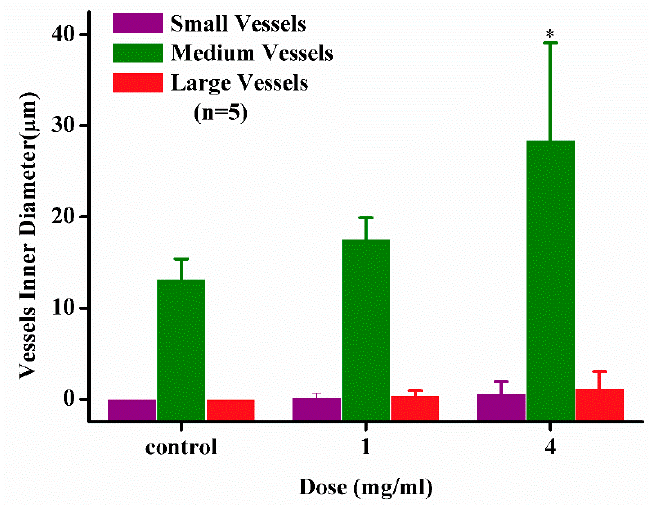
Figure 5. Effect of compound 8 on angiogenesis promotion. * p < 0.05; large vessels: inner diameter > 100 μ m; medium vessels: 10 μ m < inner diameter < 100 μ m; small vessels: inner diameter < 10 μ m.